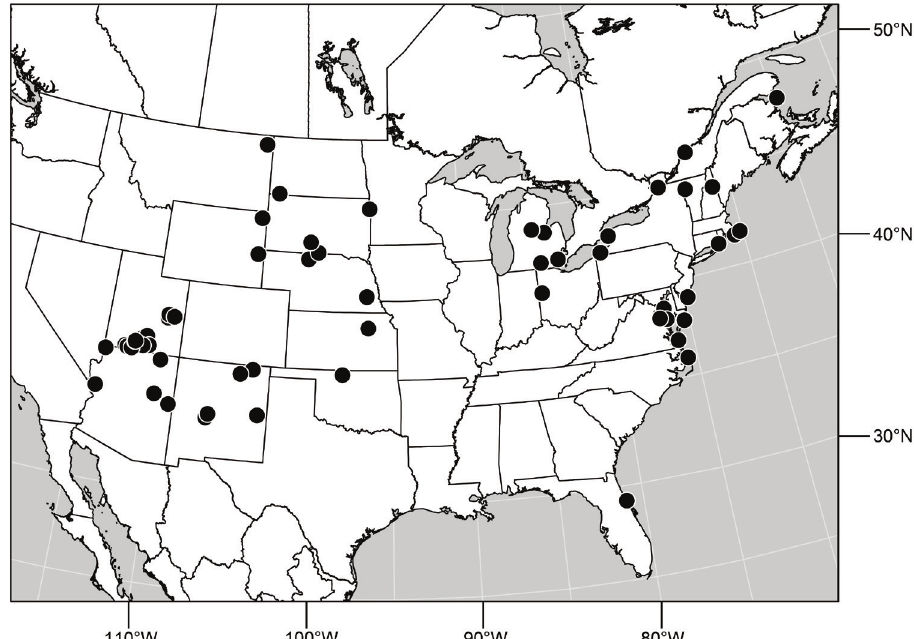
Figure 199. Distribution of Discocerina buccata ( Cresson)